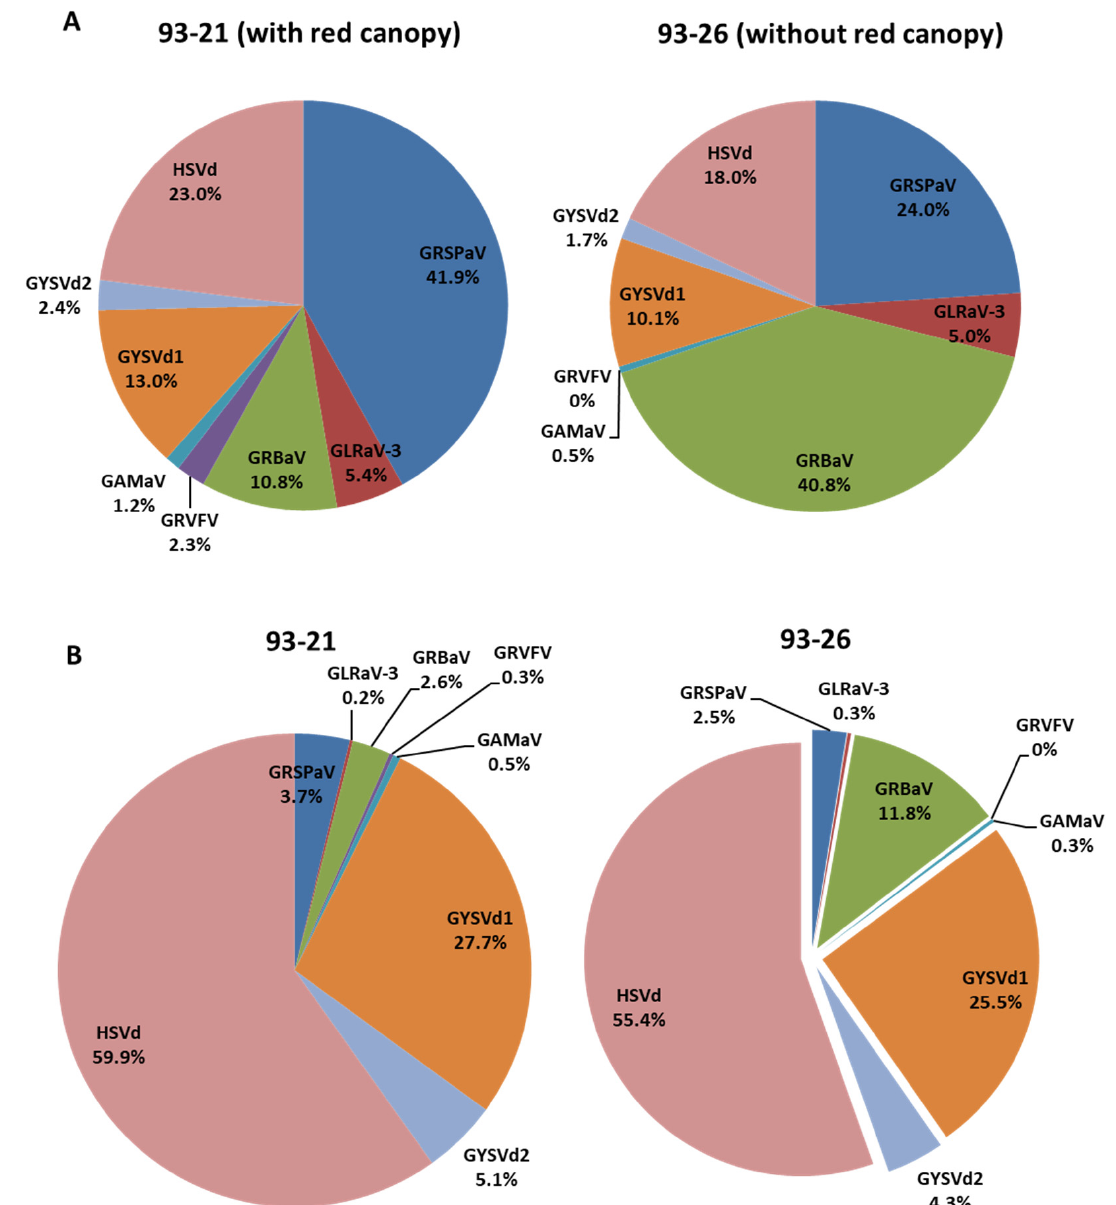
Figure 2. The distribution of viruses and viroids identified in 93-21 and 93-26 (both of Syrah clone 100) revealed by HTS. ( A ) The percentage of identified viruses and viroids was calculated as the number of sequence reads corresponding to each virus or viroid divided by the total virus and viroid reads in each sequencing library. ( B ) The percentage of identified viruses and viroids was calculated as the genome copy number of each virus or viroid over the total genome copy number of all viruses and viroids in each library. The genome copy number of each virus or viroid was calculated by multiplying the number of sequence reads specific to the virus by 51 (the number of nucleotides in each read), which was then divided by the size of the genome of the virus or